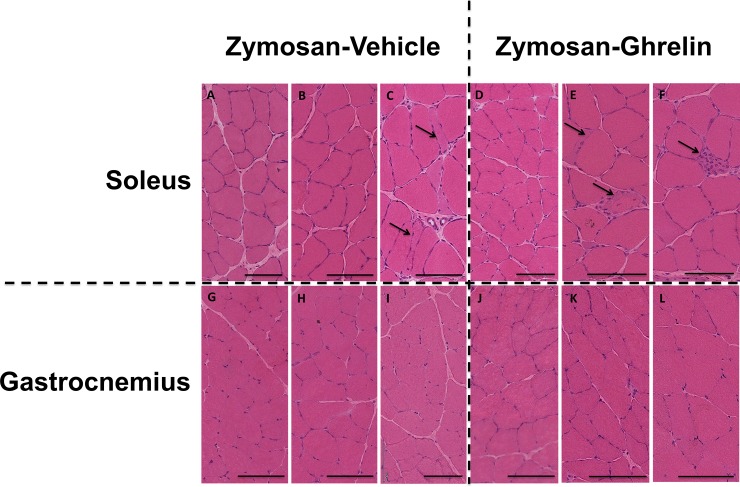
Examples of histopathological changes.The top row represent soleus (A-F) and bottom row shows the corresponding gastrocnemius (G-L). A-C and G-I were zymosan-vehicle treated animals; D-F and J-L were zymosan-ghrelin treated. A, B and D are normal, C shows mild pathology–rare atrophic fibers. E and F show rare atrophic fibers and also regenerating fibers. All gastrocnemius (G-L) in the bottom row are normal. The scale bar in each image equals 100 microns.